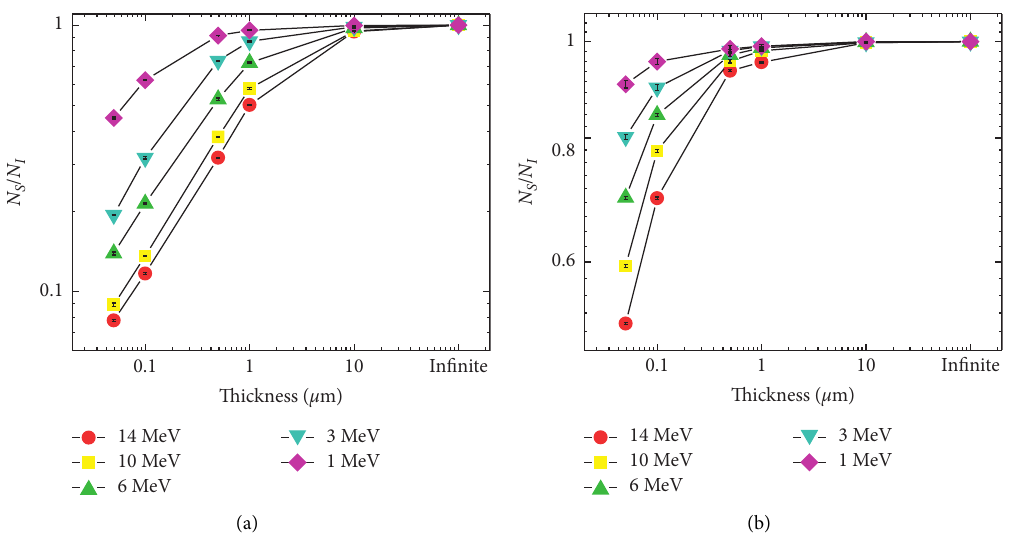
Figure 3: Influence of thickness on N d for different neutron energies: (a) Si and (b) Nb.